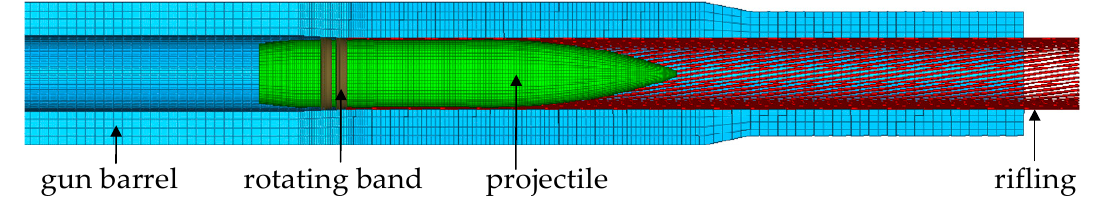
Figure 2. Barrel-projectile finite element model. Table 2. Material parameters of the barrel-projectile finite element model.